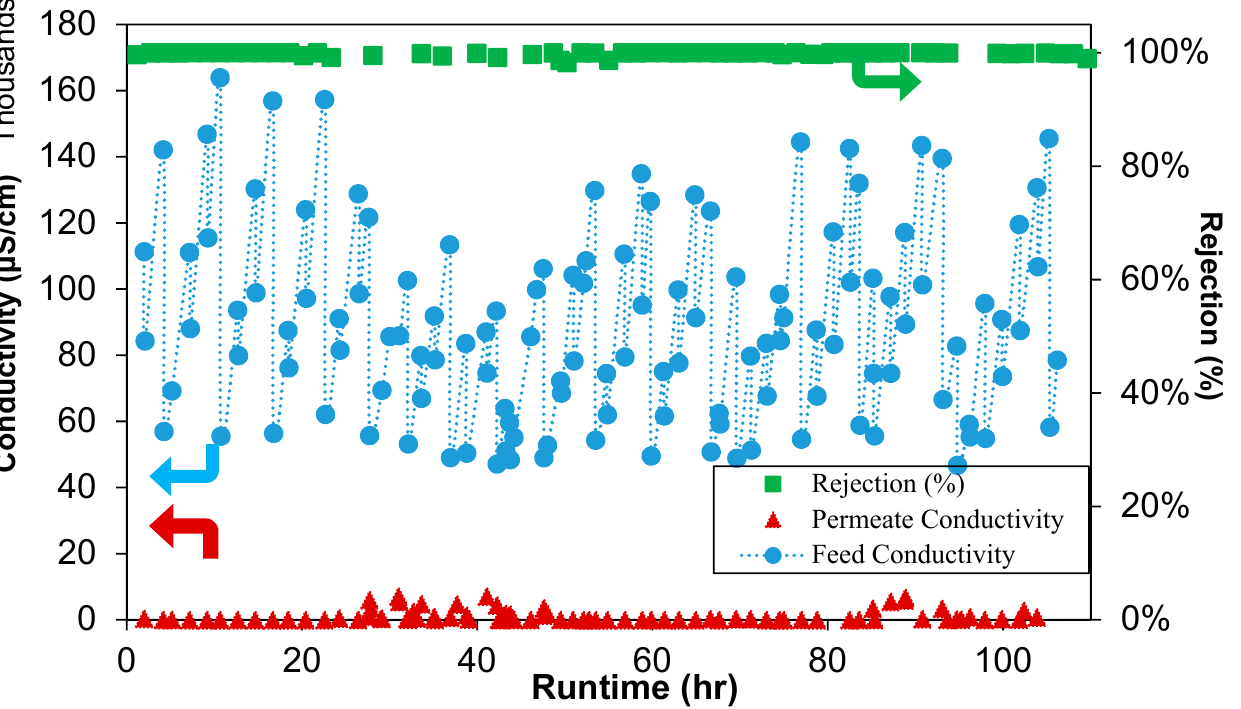
Figure 8. Rejection and conductivity of the feed and permeate as a function of runtime from pilot tests using a 2-inch module.